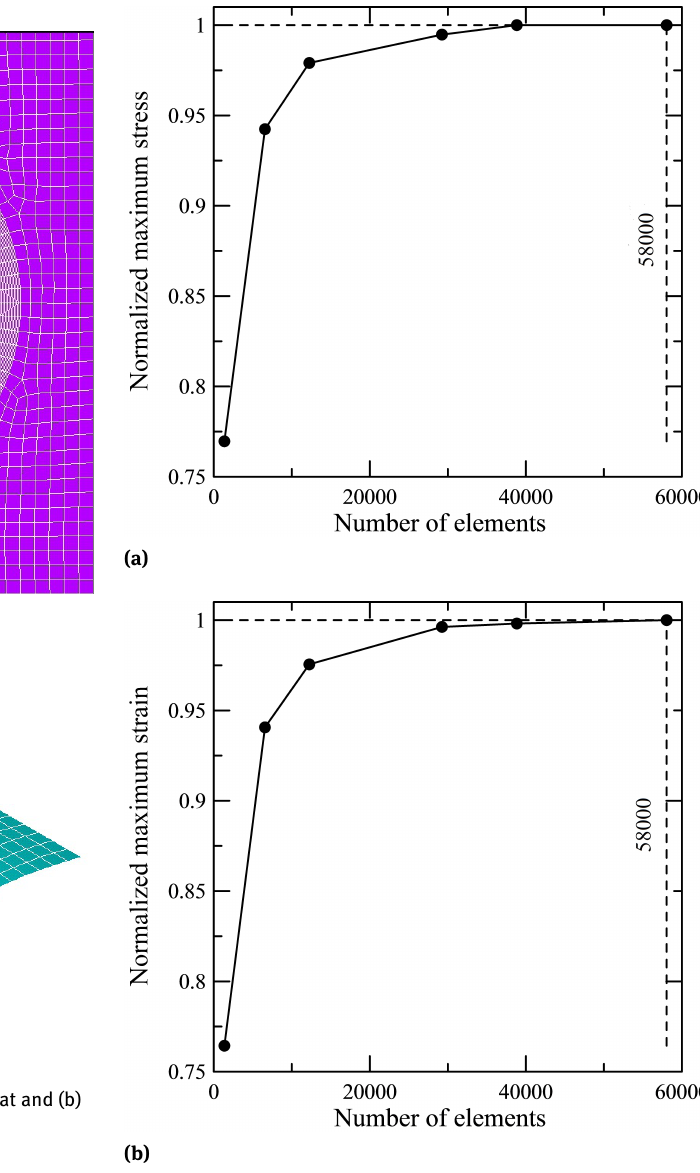
Figure 5: Mesh sensitivity plot for normalized: (a) maximum stress ( 𝜎 𝑥 ) and (b) maximum strain